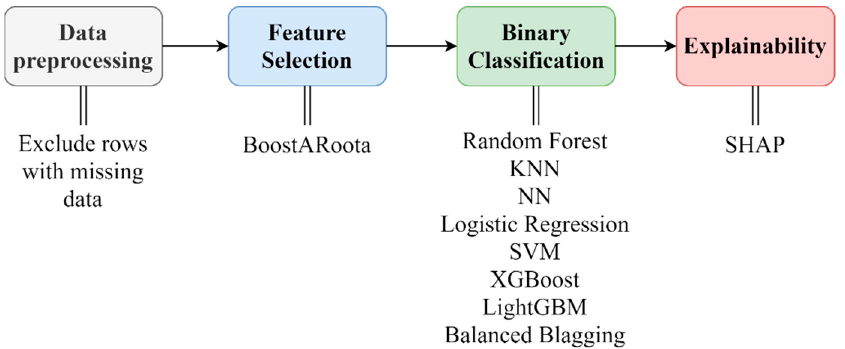
Figure 1. Methodology